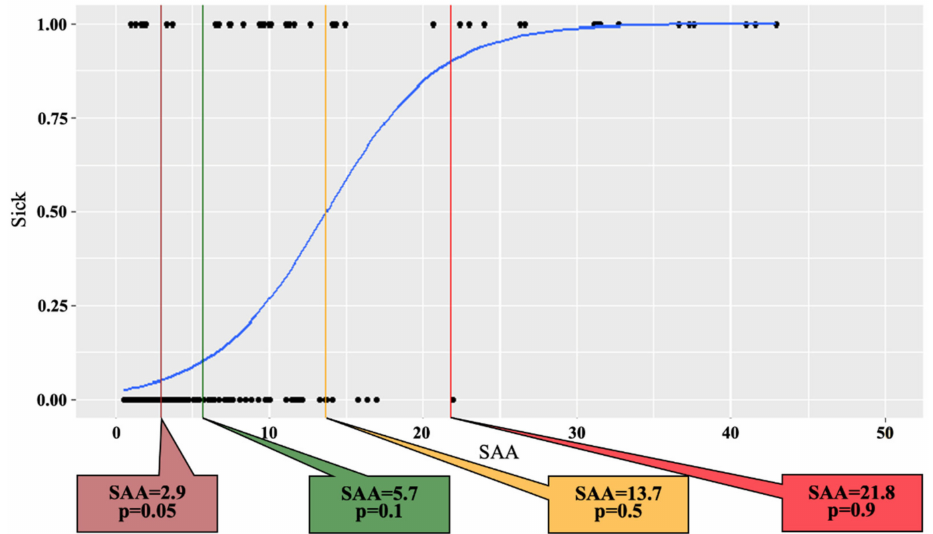
Figure 2. Proposed diagnostic cut-off points of serum amyloid A concentrations to differentiate between healthy ( n = 289) and diseased ( n = 66) groups of Japanese Black breeding cows evaluated with each probability ( p = 0.05, 0.1, 0.5, and 0.9) by the logistic regression analysis.